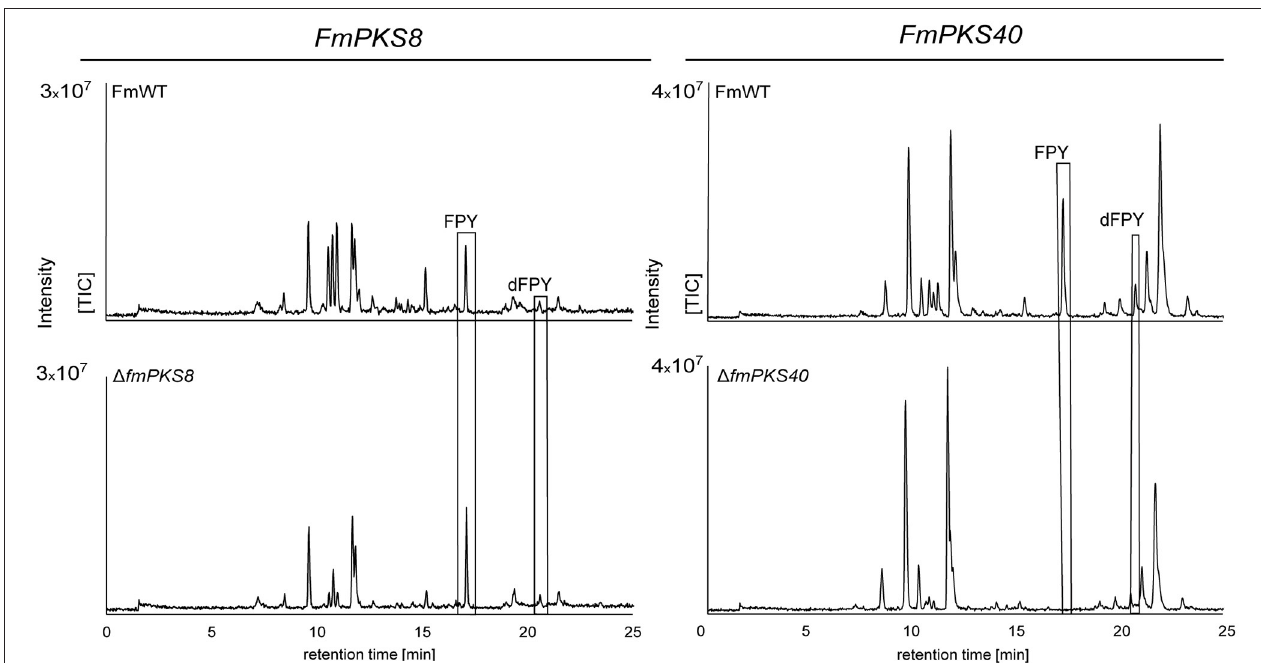
FIGURE 7 | HPLC-HRMS chromatograms of fusapyrone (FPY) and deoxyfusapyrone (dFPY) production in 1 fmPKS8 and 1 fmPKS40 cultures. F. mangiferae wild-type (FmWT) and indicated deletion strains were cultivated for 7 days in FPY-inducing media. Experiments were performed in triplicates. The measurement of fungal supernatants revealed that no FPY and dFPY is produced in 1 fmPKS40 cultures, while 1 fmPKS8 retained wild type-like production levels. TIC chromatograms (positive ESI-mode) range from m / z 100 to